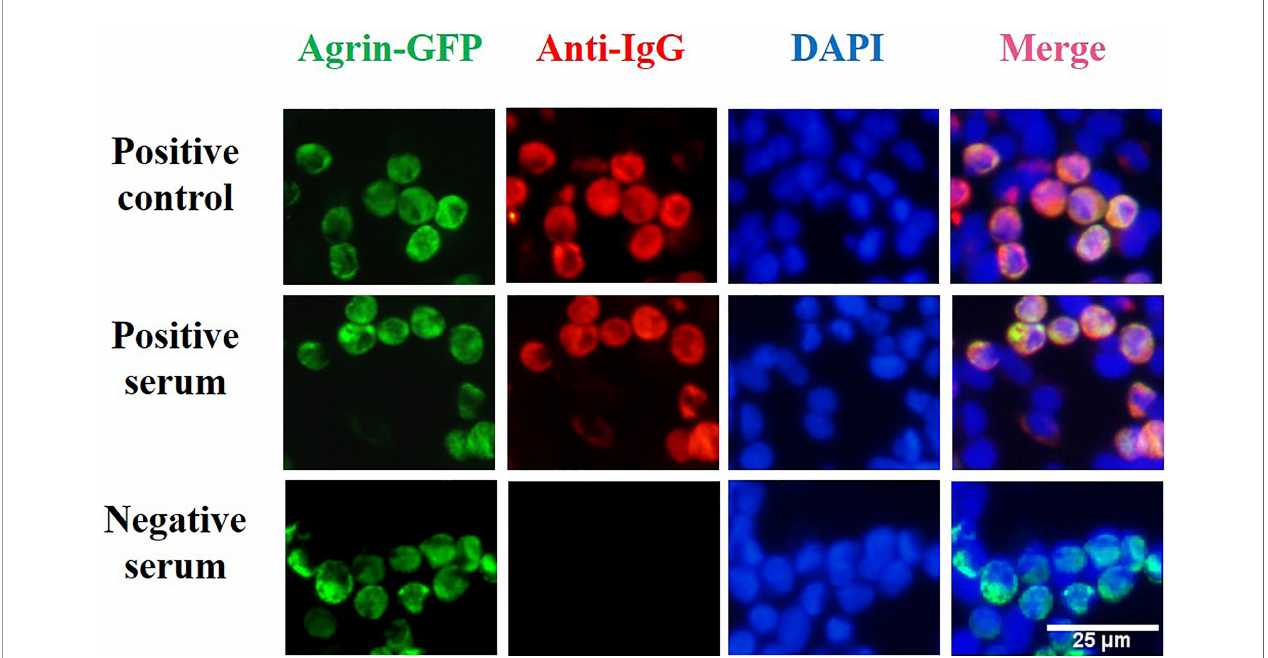
FIGURE 3 | Cell-based assay for the detection of agrin antibodies. HEK293T cells were transfected with a plasmid construct encoding agrin-GFP fusion to develop a cell-based assay for the detection of agrin antibody. After transfection of HEK293T cells with the plasmid construct encoding the fusion protein, green fl uorescence was used to con fi rm fusion protein expression in transfected cells. In our cell-based assay, the binding of IgG in the patient serum is con fi rmed by red fl uorescence. Positive control (DF9181,Af fi nity Biosciences, OH, USA), HC serum, and Agrin-MG serum staining of transfected cells. The complete overlap of red fl uorescence and green fl uorescence indicates the presence of anti-Agrin